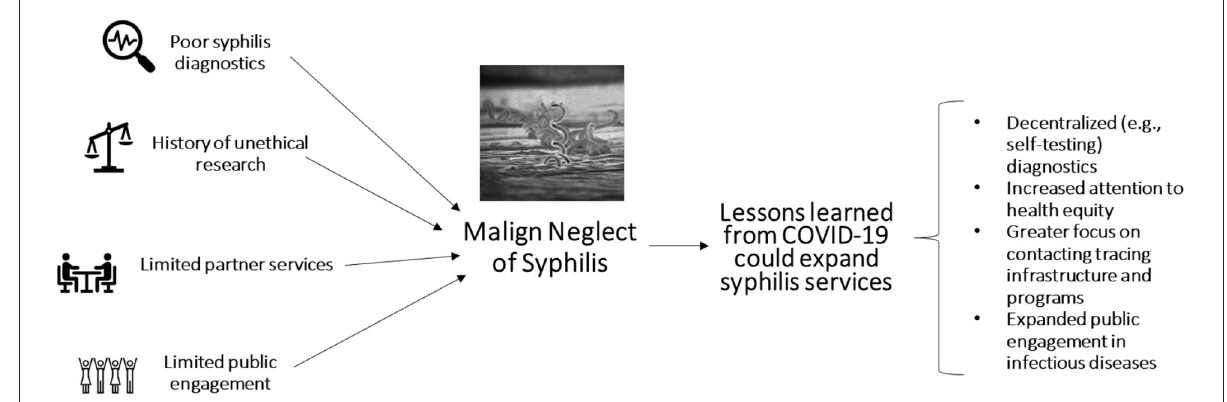
FIGURE1 Overview of the malign neglect of syphilis within comprehensive STI control